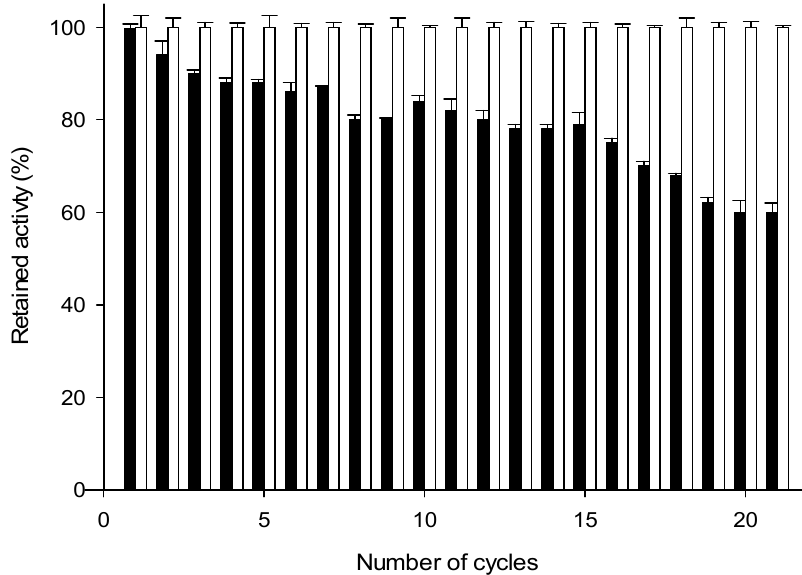
Figure 6. Reusability of the M Lm PDT3/M Ec HPRT3 system. 2 ′‐ deoxyribosyltransferase activity, reaction 1 (black bar); phosphoribosyltransferase activity, reaction 2 (white bar).